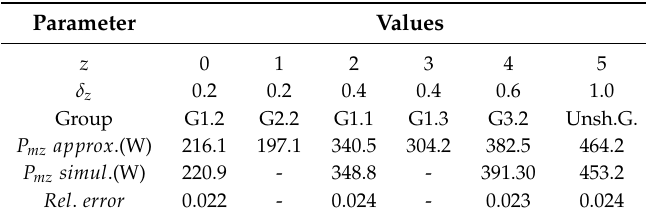
Table 3. Maximum power points—Case: shaded